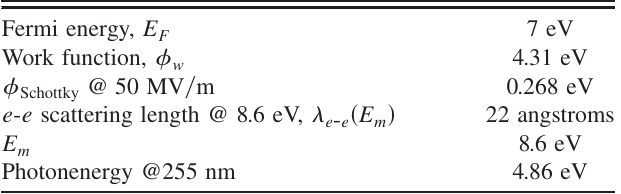
TABLE I. Physical constants used to compute the thermal emittance and quantum efficiency for atomically clean copper [5]. Fermi energy, E F 7 eV Work function, (cid:1)